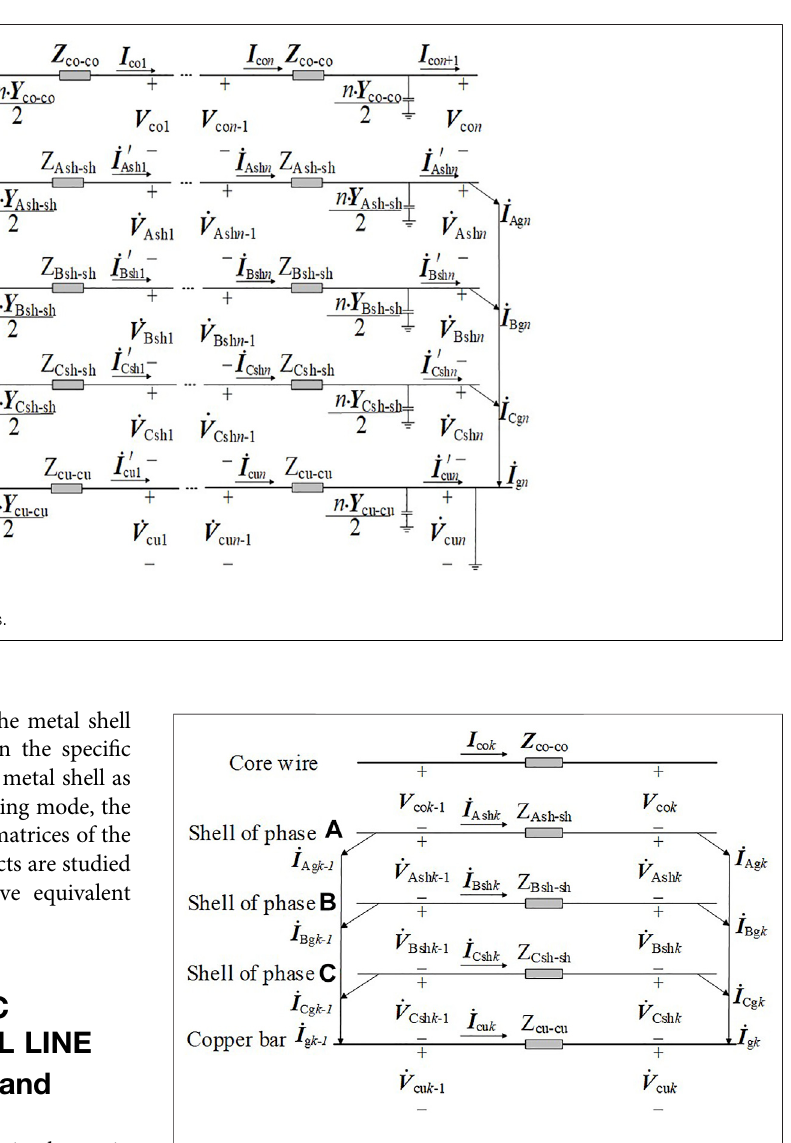
FIGURE 4 | GIL equivalent circuit in the middle